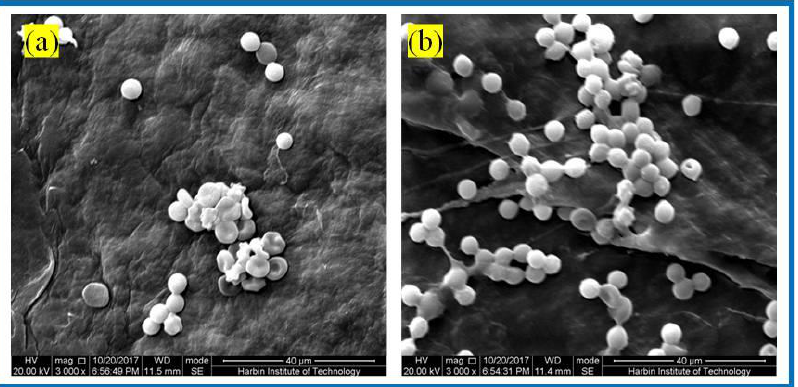
Figure 9. SEM of RBCs fixation of: ( a ) BC membranes and ( b ) PLA/BC-3 composite scaffolds.